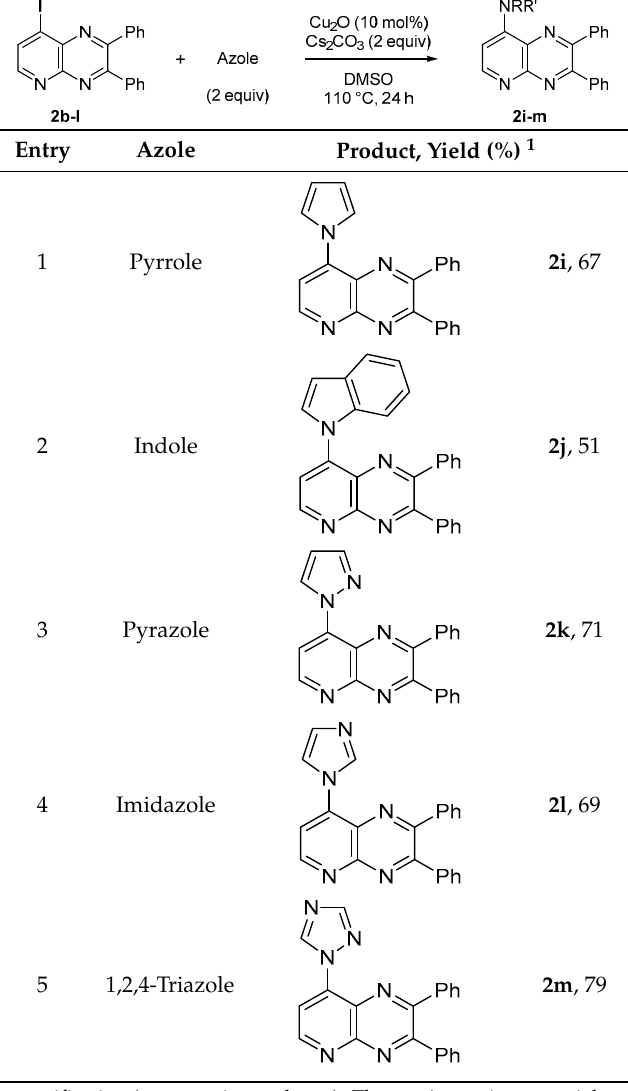
Table 4. Copper-catalyzed N -arylation of 8-iodo-2,3-diphenylpyrido[2,3- b ]pyrazine ( 2b-I ) using azoles.